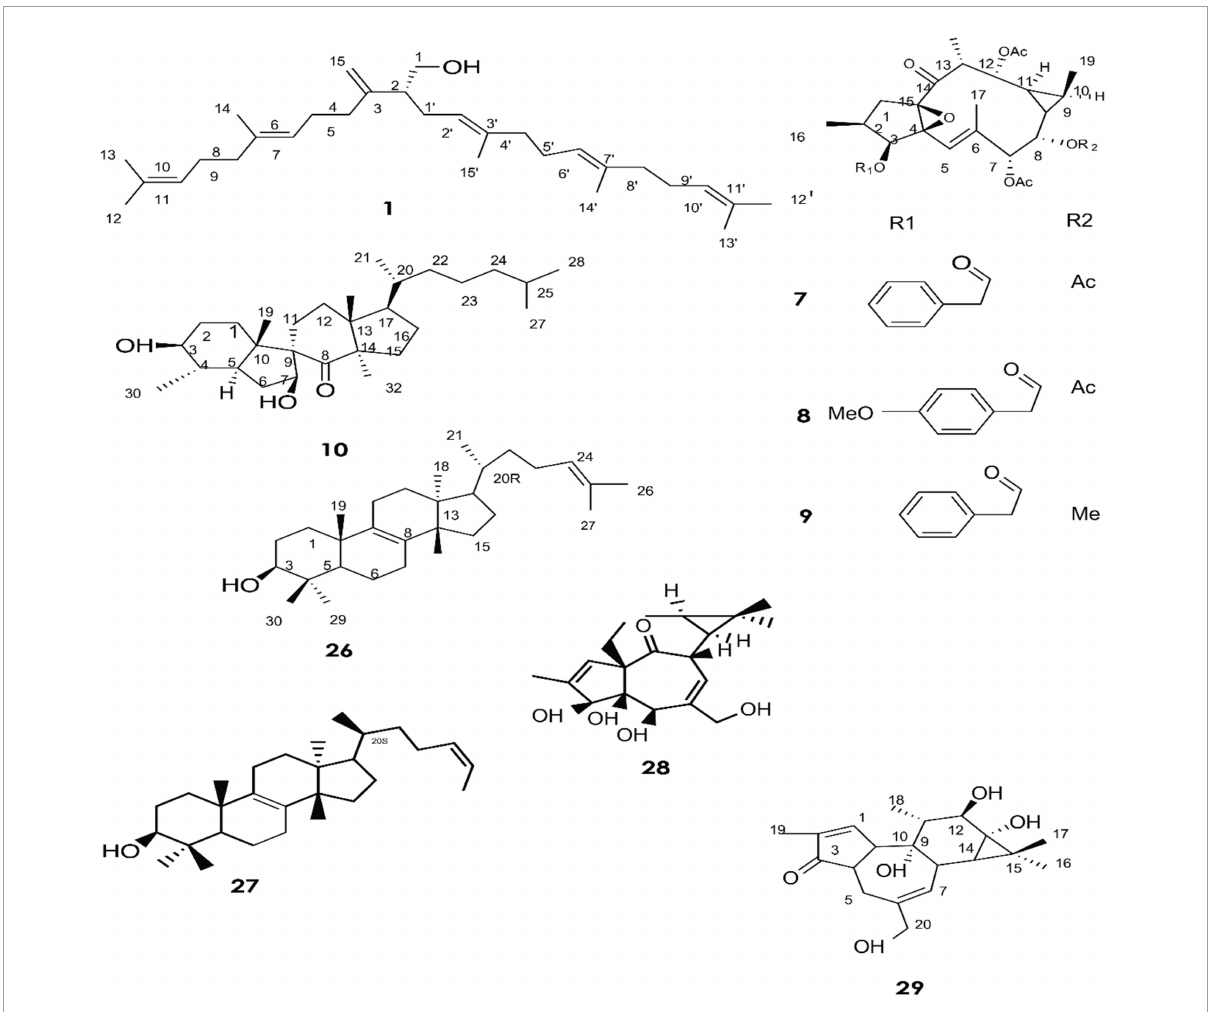
FIGURE1 Structure of chemicals compound 1, 7-10, 26-29 ( Giner et al., 2000; Daoubi et al., 2007; de Souza et al.,